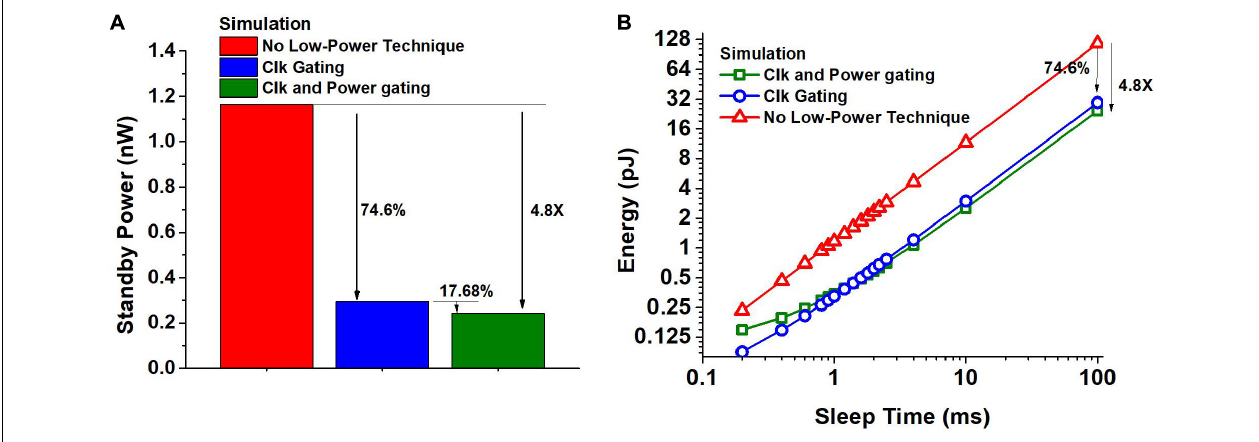
FIGURE 4 | (A) Impact of spike-driven clock gating and a combination of clock and power-gating on the standby power consumption of a hidden neuron obtained using SPICE simulation. (B) Energy consumption of the hidden neuron obtained using SPICE simulation as a function of sleep time between two spikes, when the clock is free running and when clock gating and power gating are